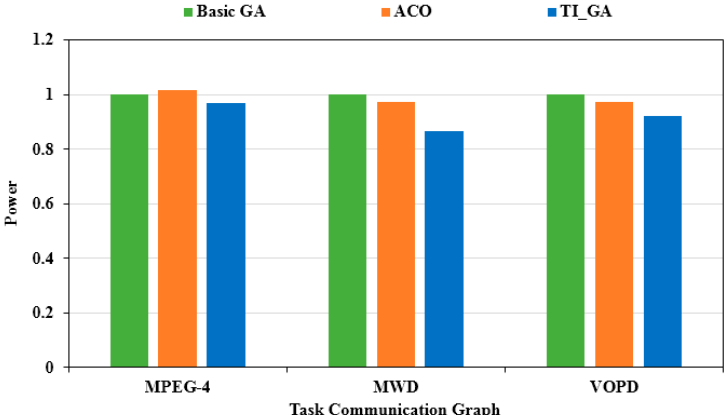
Figure 8. TI_GA, traditional genetic algorithm and ACO for MPEG-4, MWD, VOPD power results comparison ( µ e : µ d = 1:1).